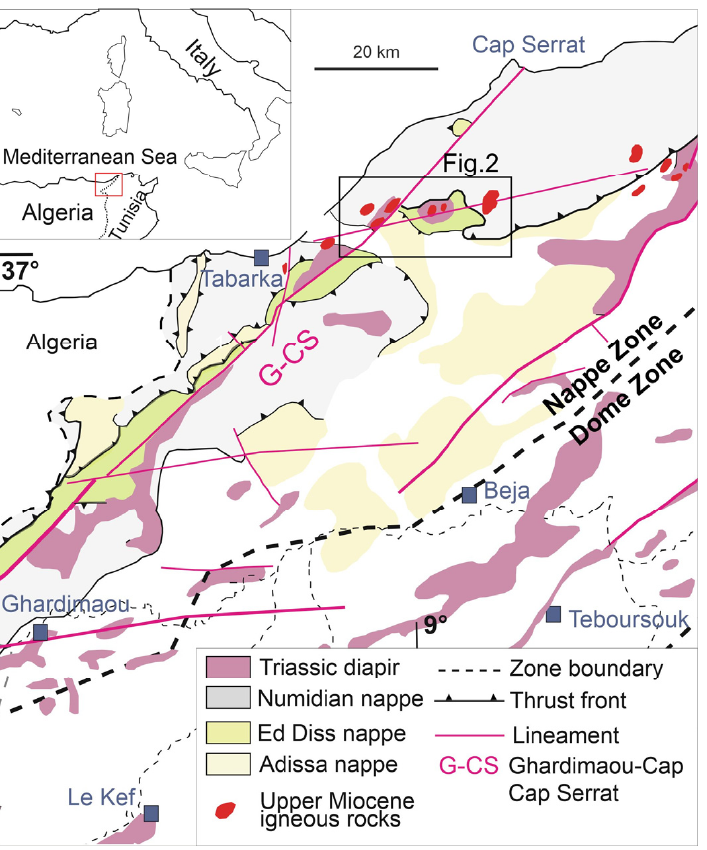
Figure 1. Tectonic map of central and northern Tunisia, showing the location of the studied area (Figure 2; modified after references [4,12–14].